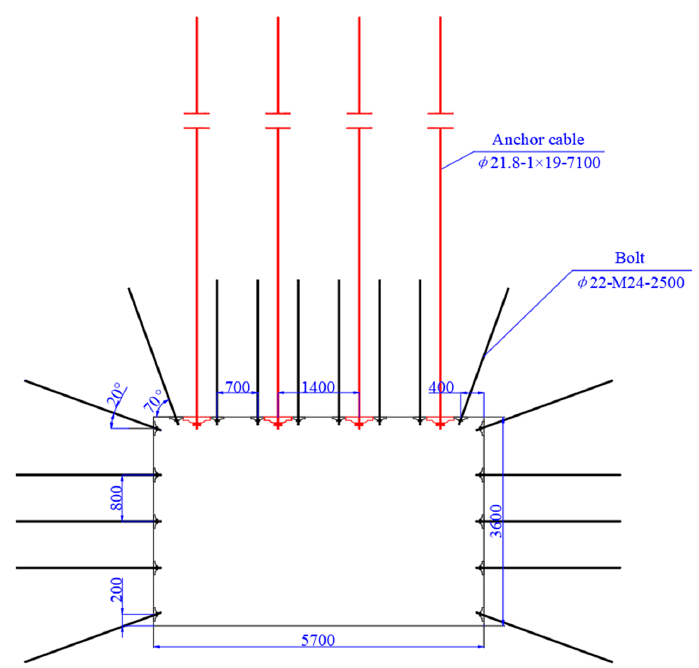
Figure 2. Roadway support parameters.